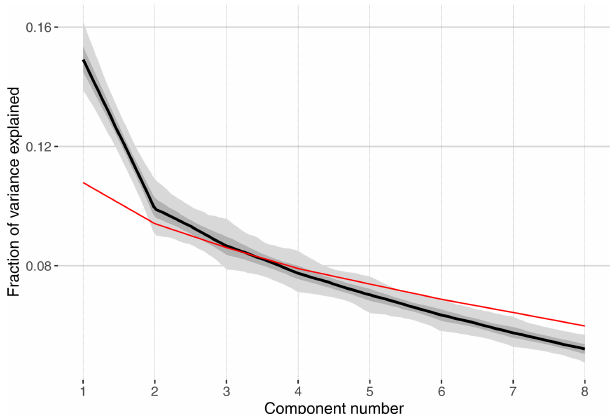
Figure 8. Ensemble PCA scree plot showing the fraction of vari- ance explained as a function of component (or eigenvalue) number. The ensemble PCA results for the data have uncertainty due to age uncertainty. The median is shown in black, and the 50% and 95% highest-probability density regions are shown in dark and light gray, respectively. The 95th percentile of the null hypothesis test is shown in